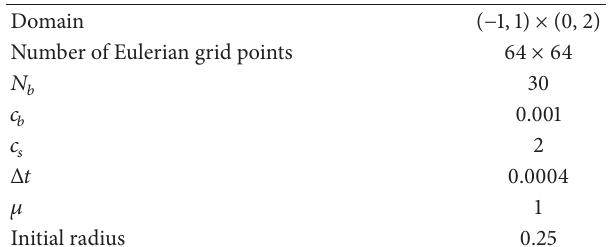
Table 1: Values of constants associated with the case of